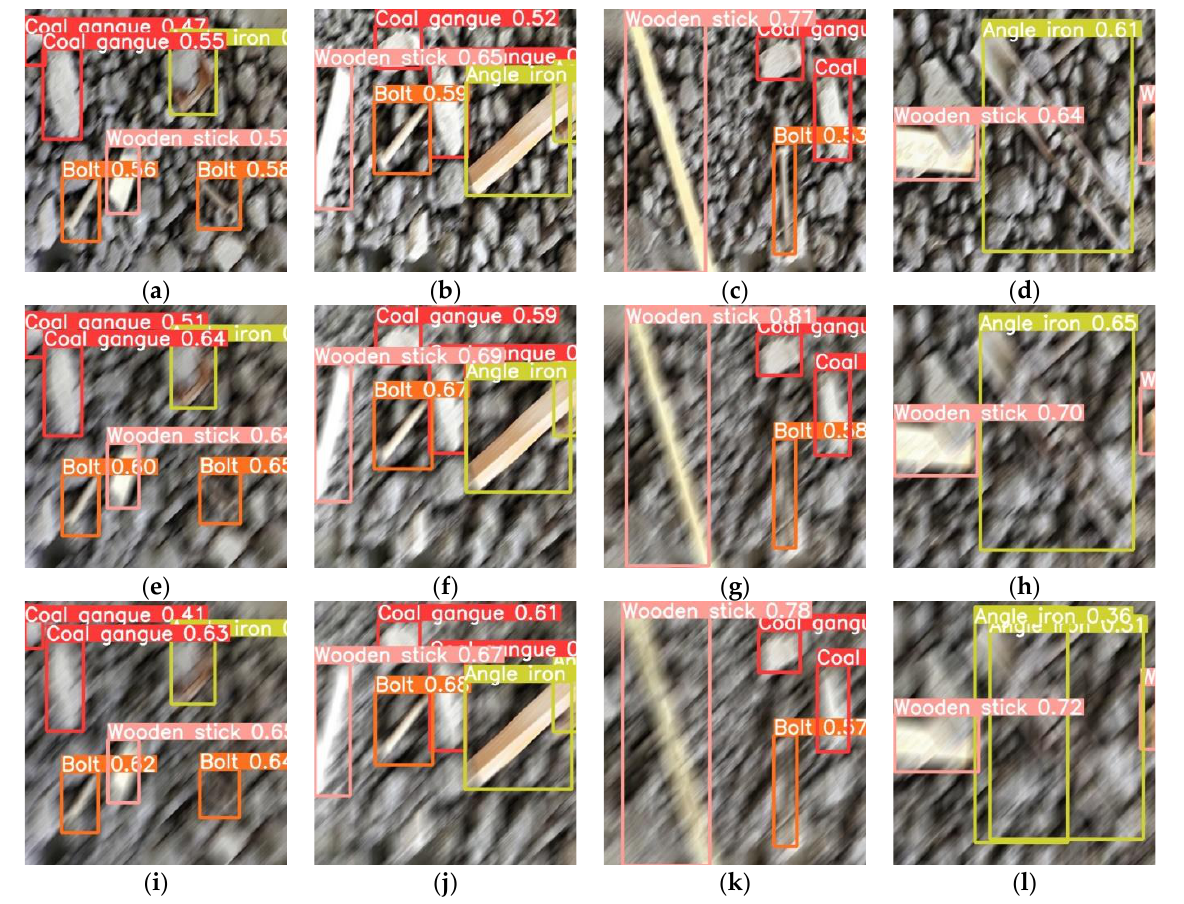
Figure 9. Detection results of blurred images after online data enhancement, ( a – d ) belong to the result achieved by the original Yolov5-s network, ( e – h ) are the detection results achieved by the improved network when the pruning rate is 0.8, and ( i – l ) are the detection results when the pruning rate is 0.9.